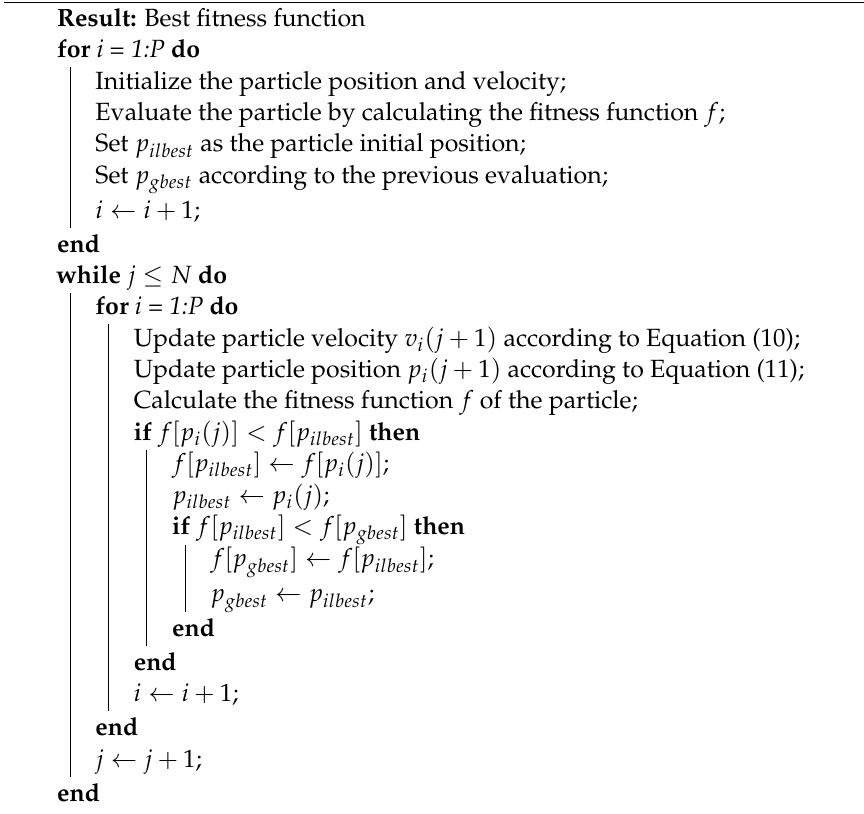
Algorithm 1: Particle Swarm